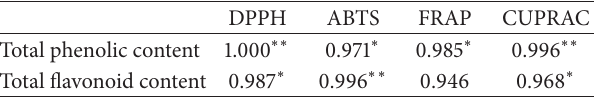
Table 8: Correlation coefficients ( 𝑟 ) between the total phenolic and flavonoid contents and the antioxidant activity of O. japonicus